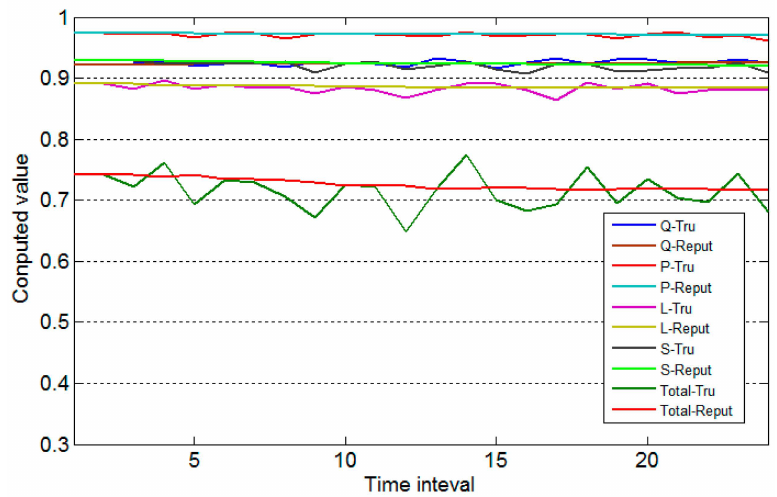
Figure 6. Dynamical reputation and trust for books on Dangdang over 24